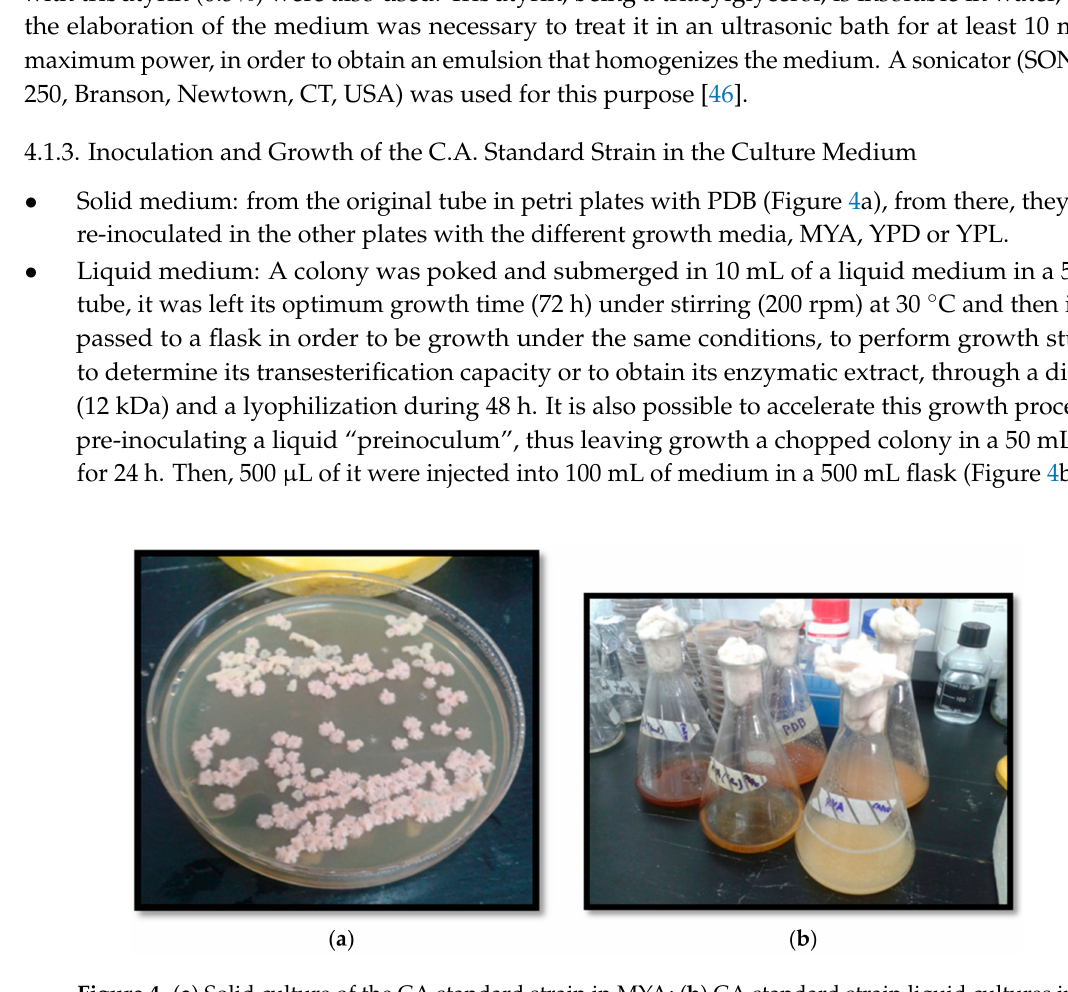
Figure 4. ( a ) Solid culture of the CA standard strain in MYA; ( b ) CA standard strain liquid cultures in different media, PDB, MYA, YPD and